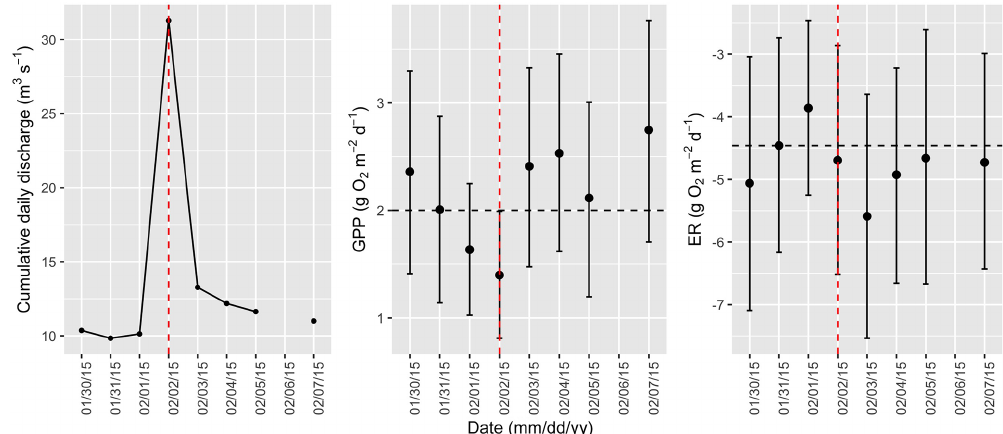
Figure A8. Cumulative daily discharge and metabolism (gross primary production and ecosystem respiration; GPP and ER) time series for the Stroubles Creek flow event on 2 February 2015 (noted with a dashed vertical red line in all three panels). The dashed horizontal black lines are mean values of GPP and ER prior to the high flow event. Error bars for posterior estimates of GPP and ER are 2.5% and 97.5% Bayesian credible intervals.